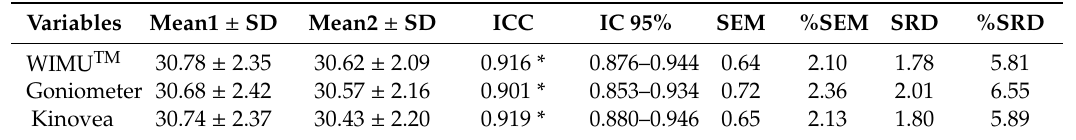
Figure 4. Bland-Altman plots with 95% limits of agreement between the WIMU TM device, universal goniometer ( left panel ), and Kinovea ( right panel ) in Phase 1 ( upper ) and Phase 2 ( lower ).